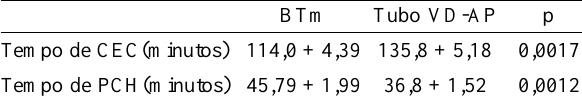
Tabela 2. Circulação extracorpórea.